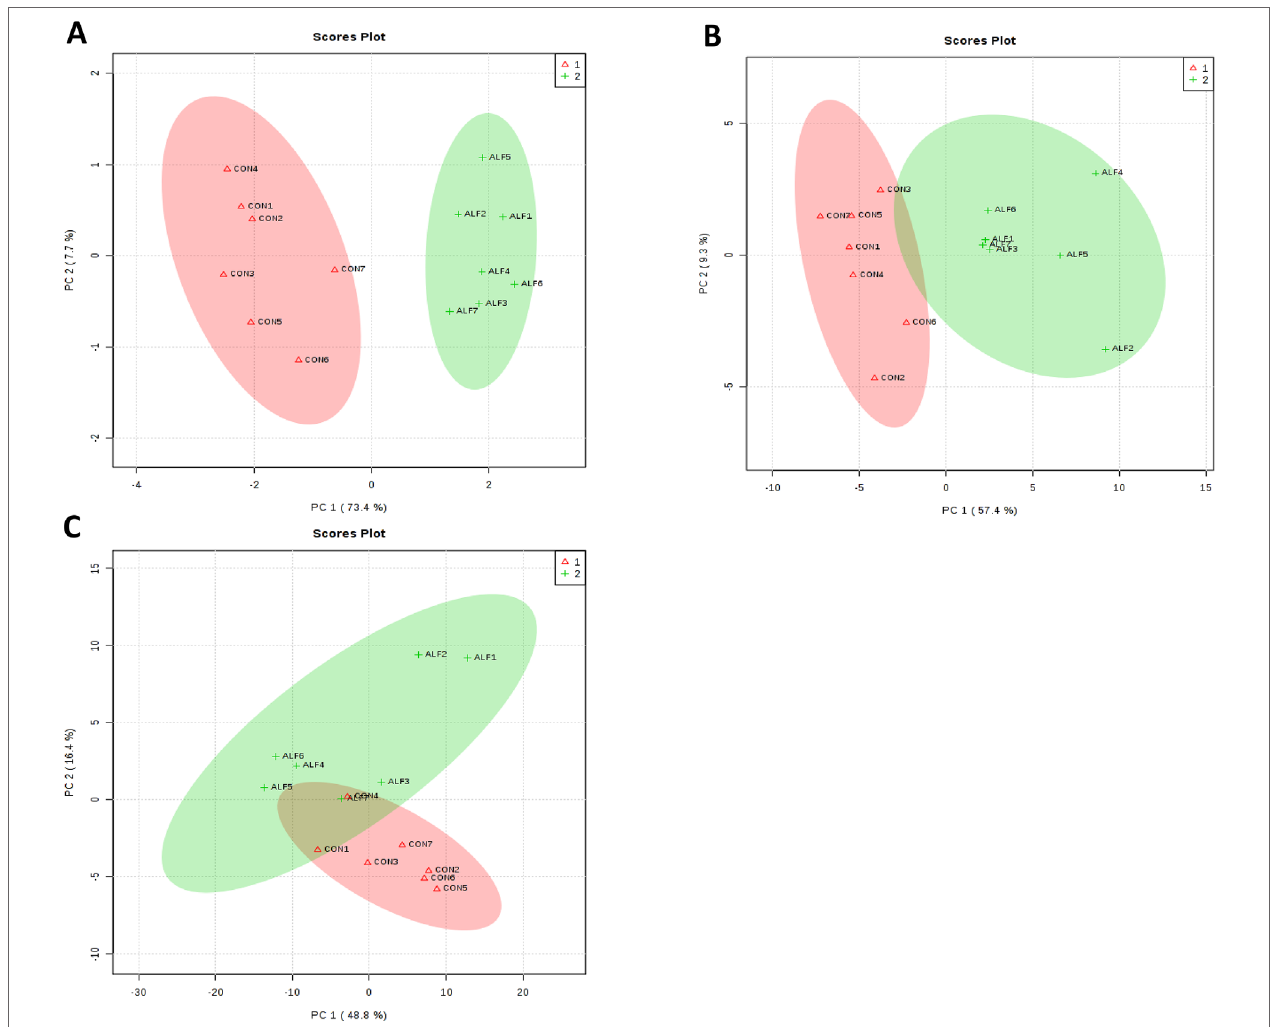
FiGURE 2 | Principal components analysis (PCA) based on gene expression profile data for the (A) LT muscle (B) liver, and (C) subcutaneous fat. Principal components analysis scores plots discriminating between the LT muscle of lambs fed concentrate CON (+) and Alfalfa (triangle).